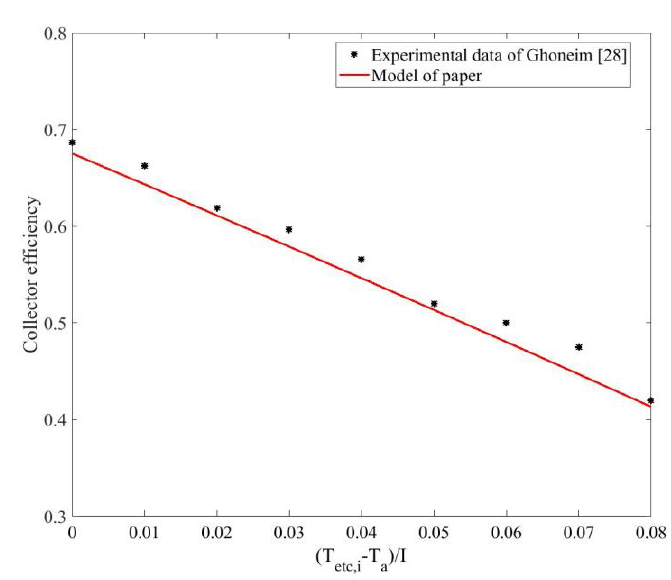
Figure 3. Validation of evacuated tube collector (ETC) model. Appl. Sci. 2020 , 10 , x FOR PEER REVIEW